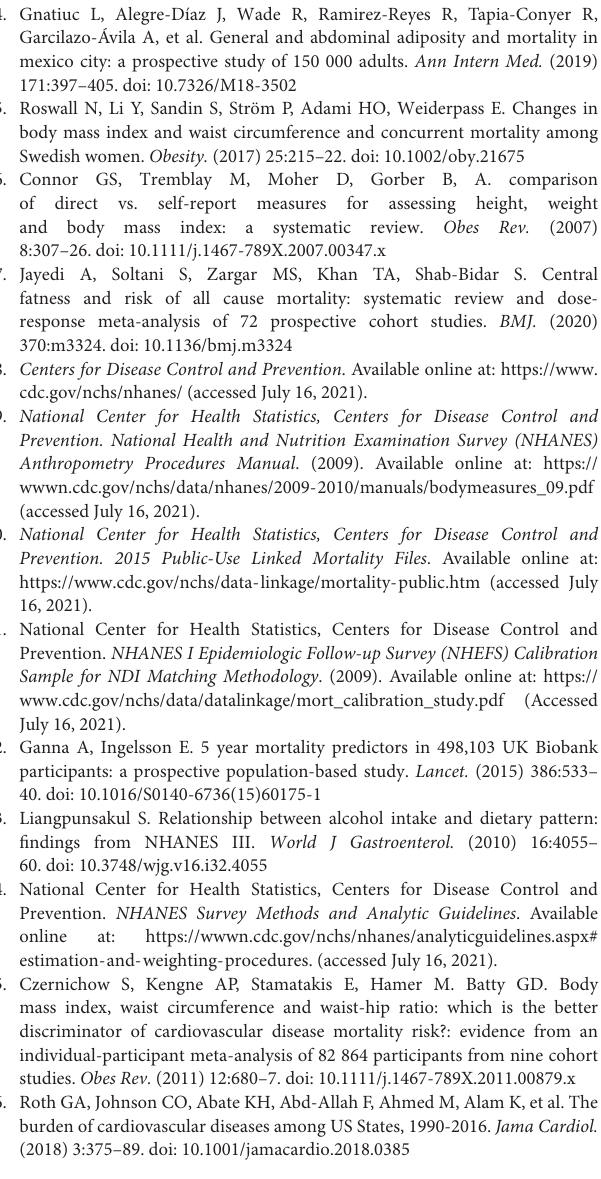
Supplementary Figure 1 | Associationsbetwen the WtHR and WC wtih all-cause and cause-specific mortality in the normal weight subgroup. Legend: Points represent the HRs, and the transverse lines represent the 95% CIs. CVD, cardiovascular disease; WtHR, waist-to-height ratio; WC, waist circumference (meter). Supplementary Figure 2 | Associations betwen the WtHR and WC wtih all-cause and cause-specific mortality in the overweight subgroup. Legend: Points represent the HRs, and the transverse lines represent the 95% CIs. CVD, cardiovascular disease; WtHR, waist-to-height ratio; WC, waist circumference